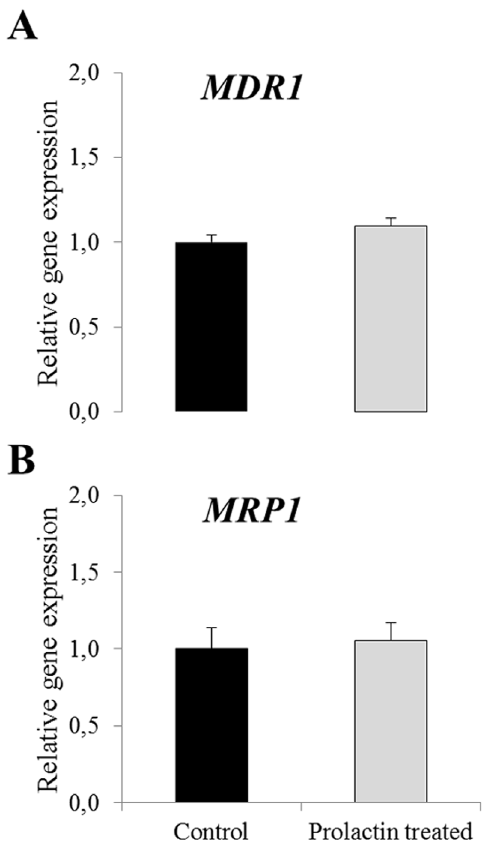
Fig 3. Relative gene expression of transporters in BME-UV cells without (control) and with lactogenic hormone stimulation (prolactin treated). Normalized gene expressions are presented as means ± SD; n = 6). Experiment repeated twice and data shown from one representative experiment.